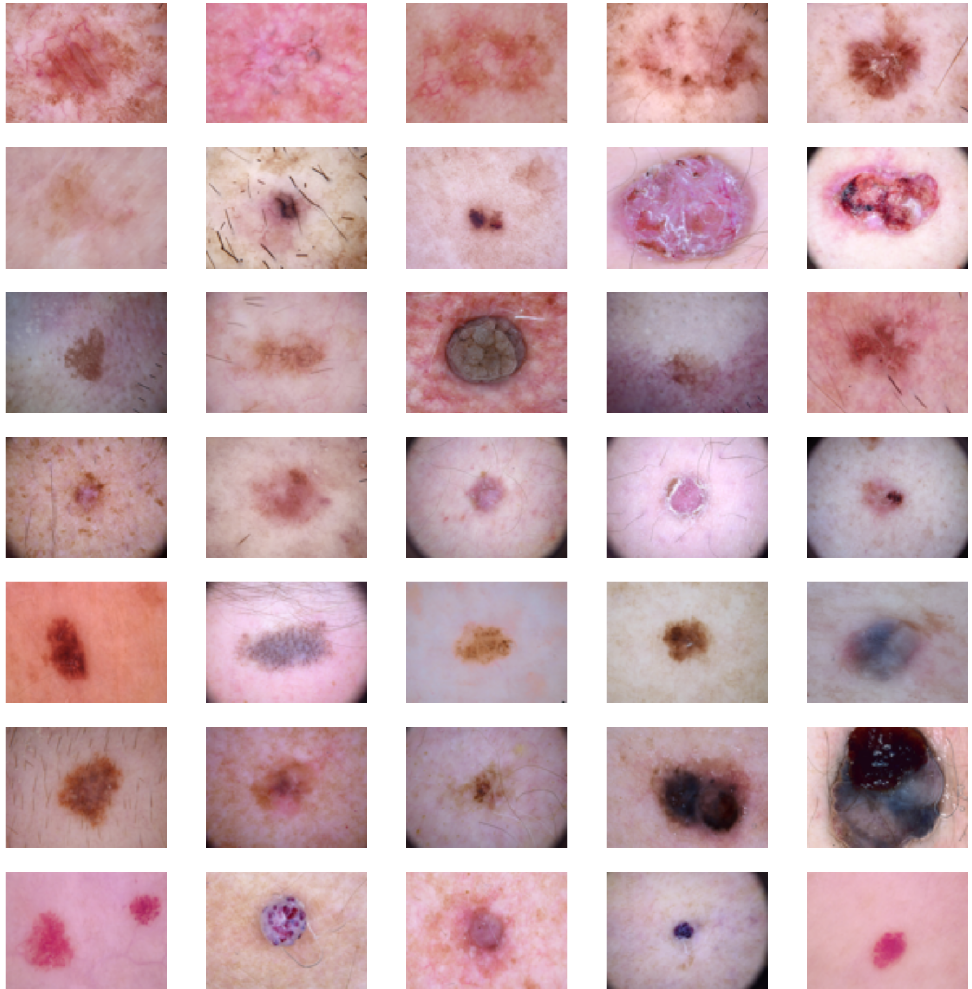
Figure 1. Example images from the seven different classes of skin lesion. For each class (from top to bottom row: askiec, bcc, bkl, df, mel, nv, and vasc), five randomly sampled instances are